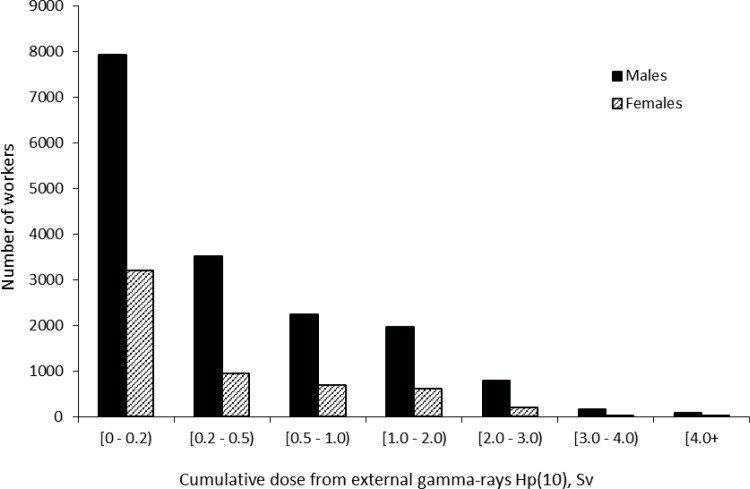
Distributions of workers from the study cohort depending on cumulative dose from external gamma-rays.